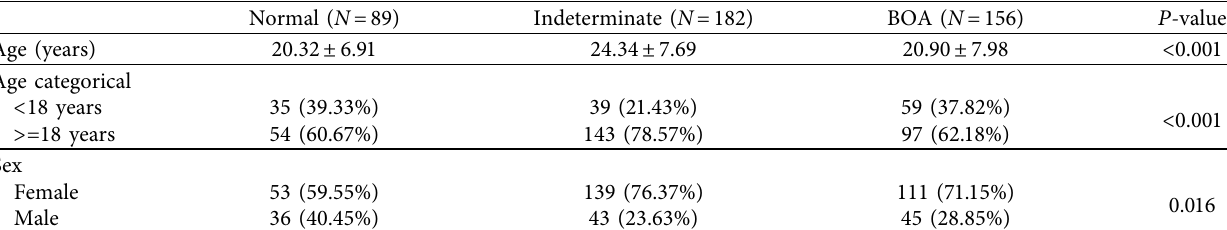
Table 2: Demographic data among the three